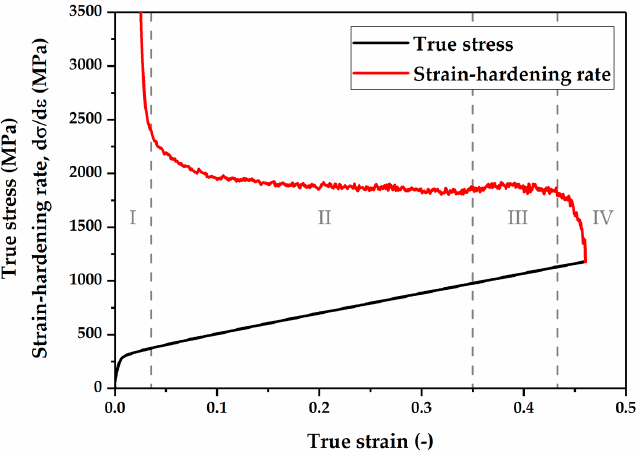
Figure 10. True strain–true stress curve and strain-hardening rate of the Fe-17Mn-1.5Al-0.3C steel tested at room temperature and a strain rate of 1 × 10 − 3 s − 1 .